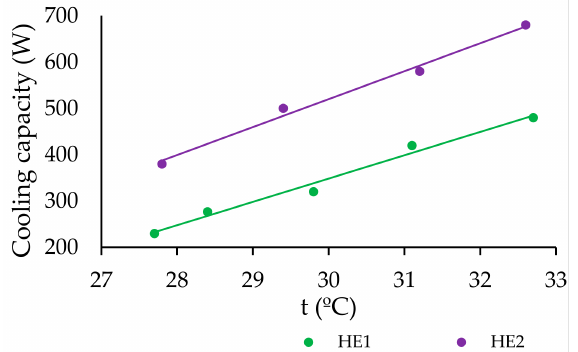
Figure 13. Effect of the inlet temperature of the primary airflow on cooling capacity [142].